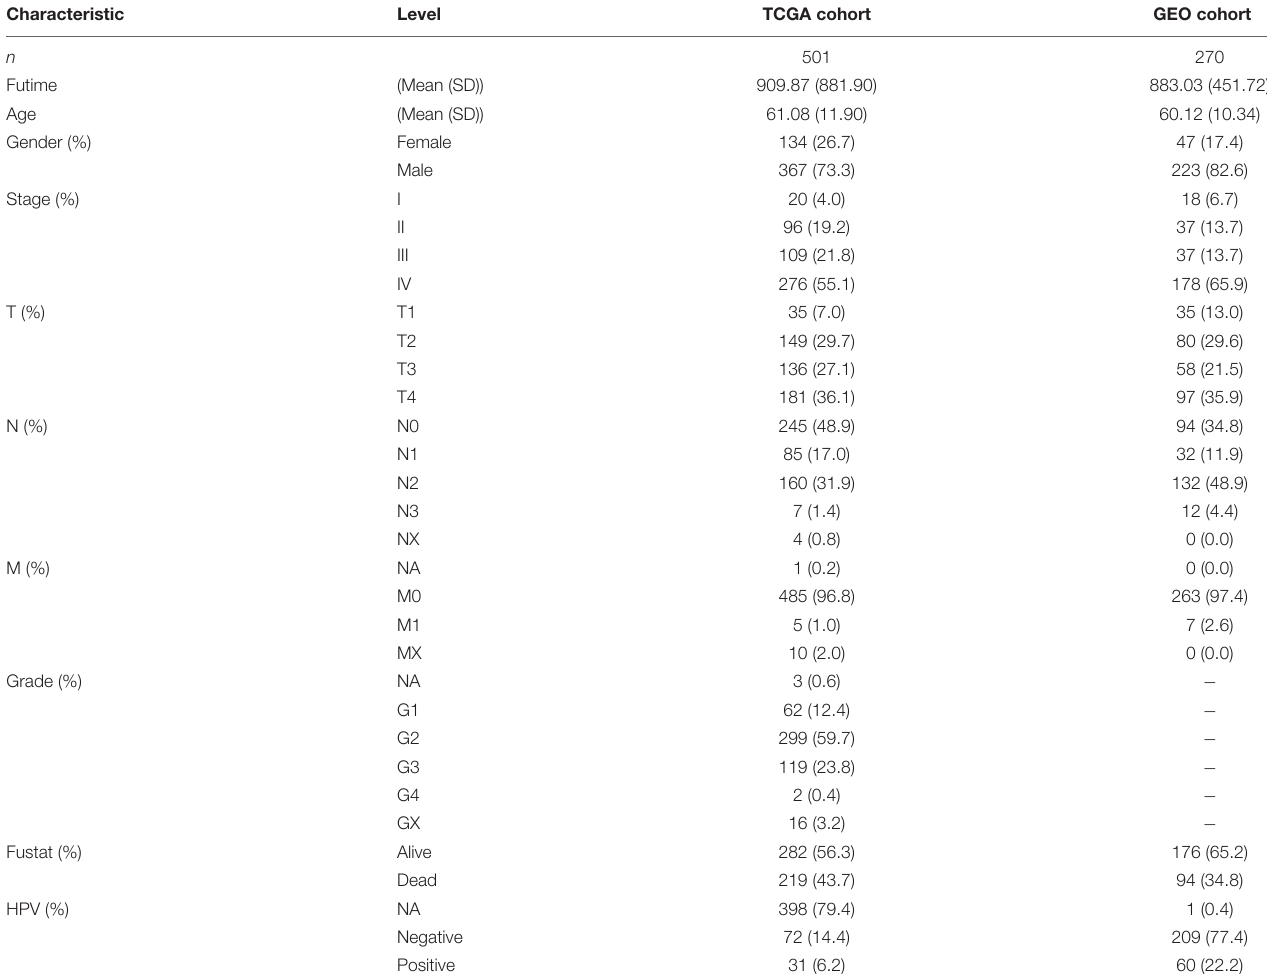
TABLE 1 | Clinical characteristics of enrolled groups.